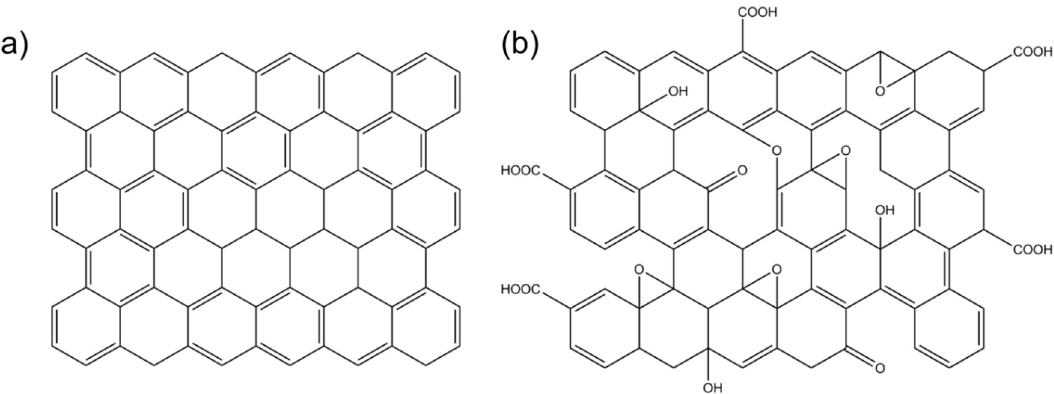
Figure 1. The structures of pristine graphene ( a ) and a model of graphene oxide ( b ). The functional groups of graphene oxide can vary depending on its method of production and its thermal and / or storage history.